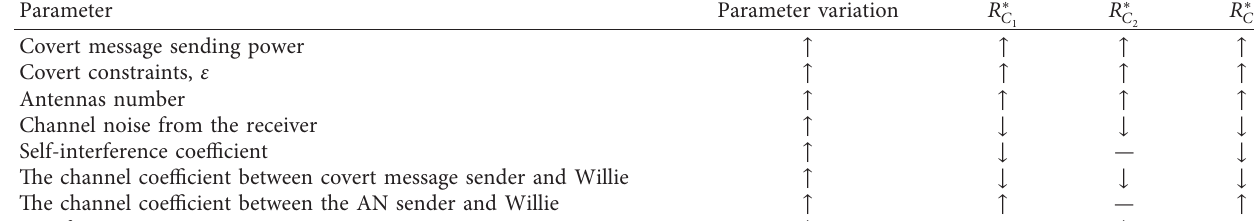
Table 3: Maximum effective covert rate results.